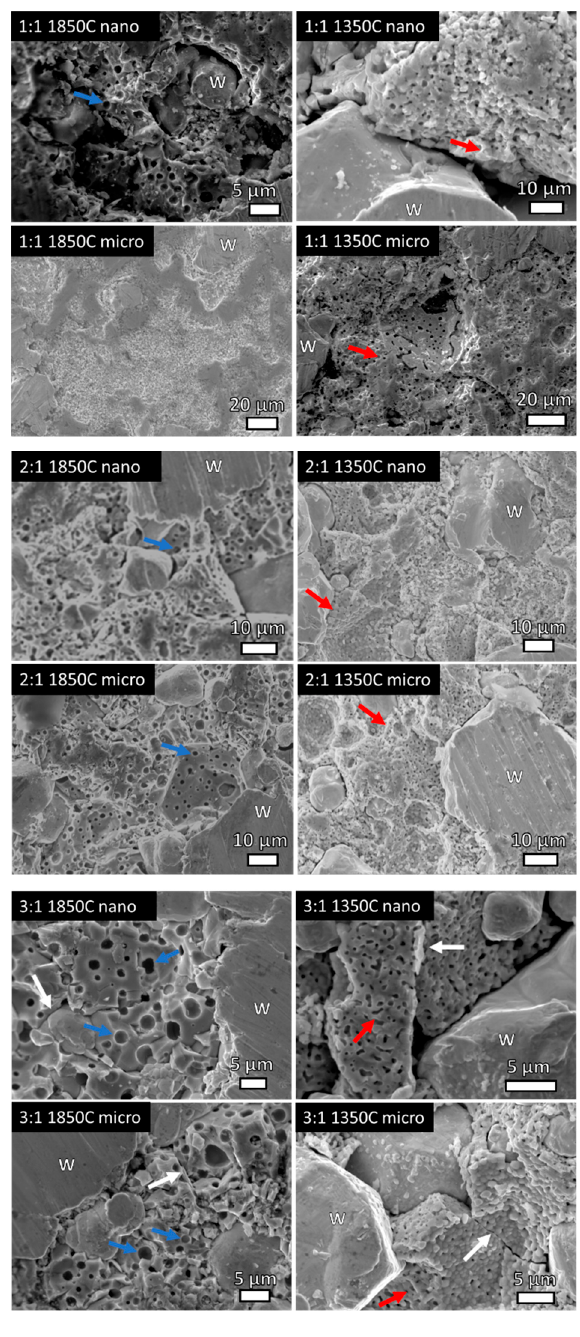
Figure 5. High-magnification SE SEM micrographs showing porosity of the CeO 2 regions in as-indicated specimens. HIP at 1850 °C shows larger, micron-sized pores and dodecahedron proto-CeO 2 grains indicative of greater consolidation. Red arrows indicate necking, white arrows indicate grain boundaries, and blue arrows indicate pores. W indicates locations of tungsten (W) grains.